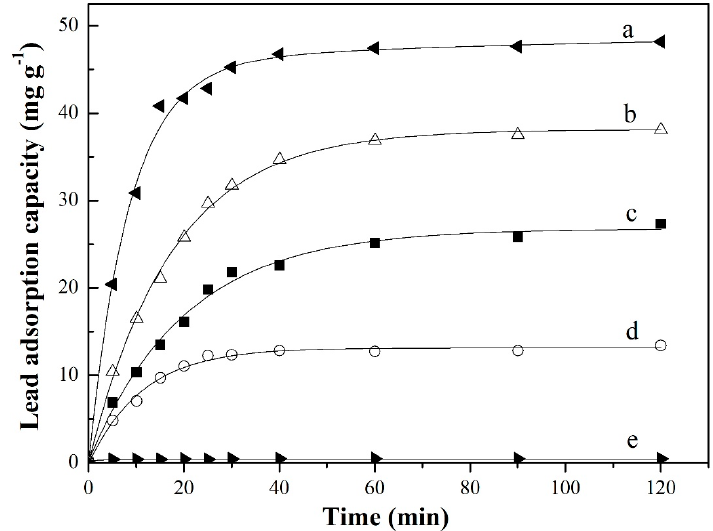
Figure 6. Adsorption kinetic models for lead ions on CSHW at different initial lead concentrations